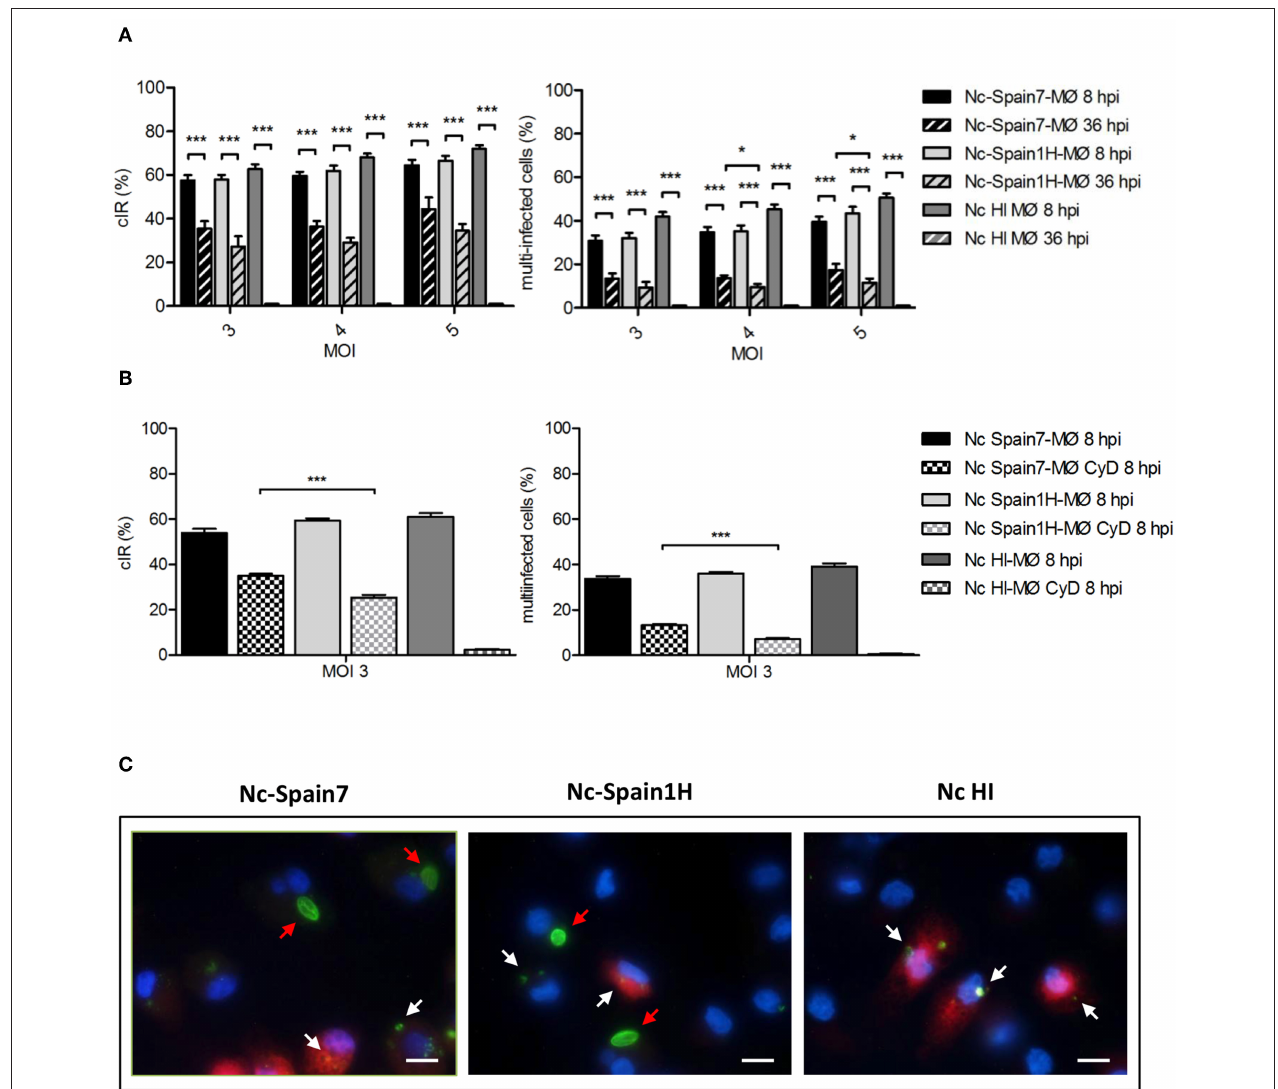
FIGURE 1 | Active invasion and parasite survival of Nc-Spain7 and Nc-Spain1H isolates in bovine MØs. (A) Graphs represent the cell infection rates at 8 and 36 hpi as the percentage of infected cells and multi-infected cells in bovine MØs for both isolates. Each column and error bar represents the mean value and SEM of three replicates from three independent experiments using MOIs of 3, 4, and 5. The total number of cells, the number of infected cells (with intact tachyzoites) and the number of cells with multi-infection were determined by double immunofluorescence staining followed by counting using an inverted fluorescence microscope. Degraded tachyzoites were found inside MØs inoculated with HI tachyzoites at 36 hpi. Significant differences are indicated (* p < 0.05; *** p < 0.001). (B) Graphs represent the cell infection rates at 8 hpi as the percentage of infected cells and multi-infected cells in untreated and Cytochalasin D treated MØs (MØ CyD) for both isolates. Each column and error bar represents the mean value and SEM of three replicates from three independent experiments using a MOI of 3. Significant differences are indicated (*** p < 0.001). (C) Representative images (at 1,000 × ) show the proliferation of Nc-Spain7 and Nc-Spain1H isolates in bovine MØs (red arrows) and the degradation of phagocyted tachyzoites in phagolysosomes (white arrows). Lysosomes stained with LysoTracker Red DND-99 are presented in red, nuclei in blue and parasites in green. Scale bar is 10 µ